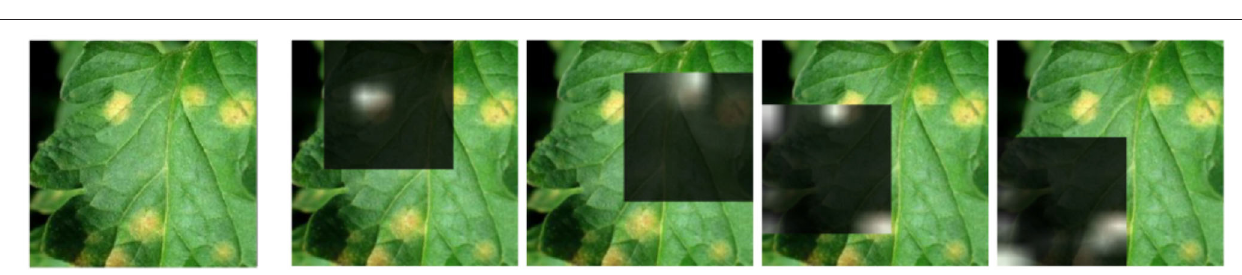
FIGURE 4 | Visualization of attention maps learned using our attention-based RNN on a leaf infected by the Leaf mold disease (to be compared with Figure 3 ). Best view in